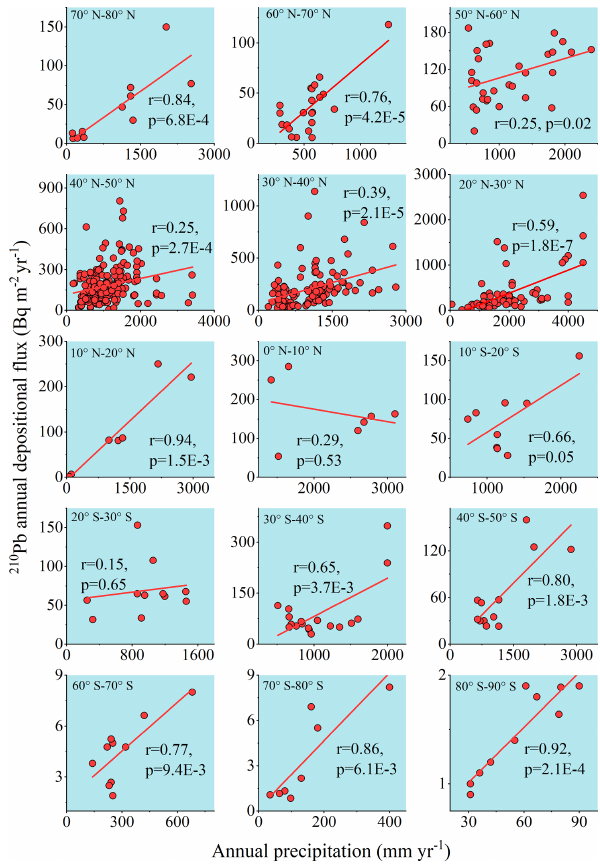
Figure 8. Annual depositional fluxes of 210 Pb are plotted against annual precipitation for 10 ◦ latitudinal bands.